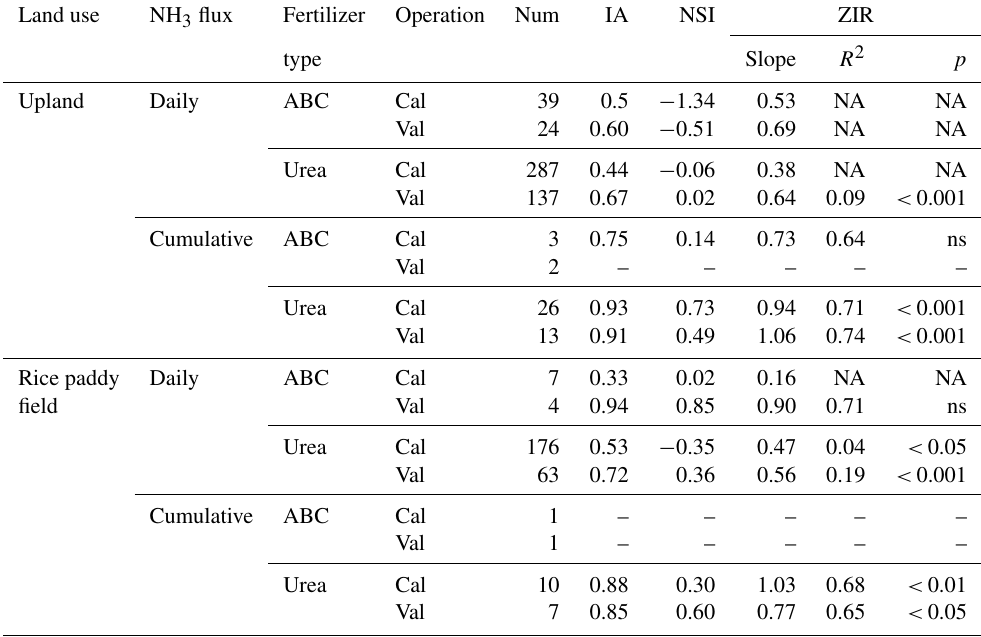
Table 3. Statistical indices for evaluating the performance of the modified CNMM–DNDC in simulating daily and cumulative ammonia (NH 3 ) fluxes from ammonium bicarbonate (ABC) and urea (including other fertilizer types) applications for the independent calibration (Cal) and validation (Val) cases in uplands and rice paddy fields.